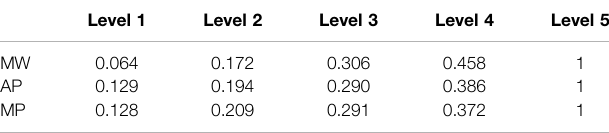
TABLE 3 | Weighting coef fi cients of each hazard factor in different intervals.